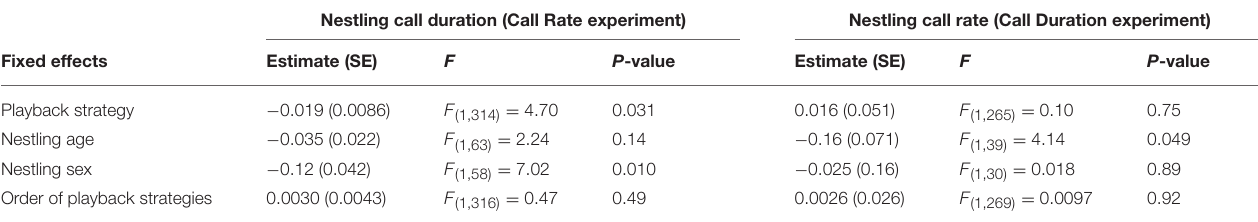
TABLE 3 | Cross-effects of the playback strategies on the vocal behavior of nestling barn owls.